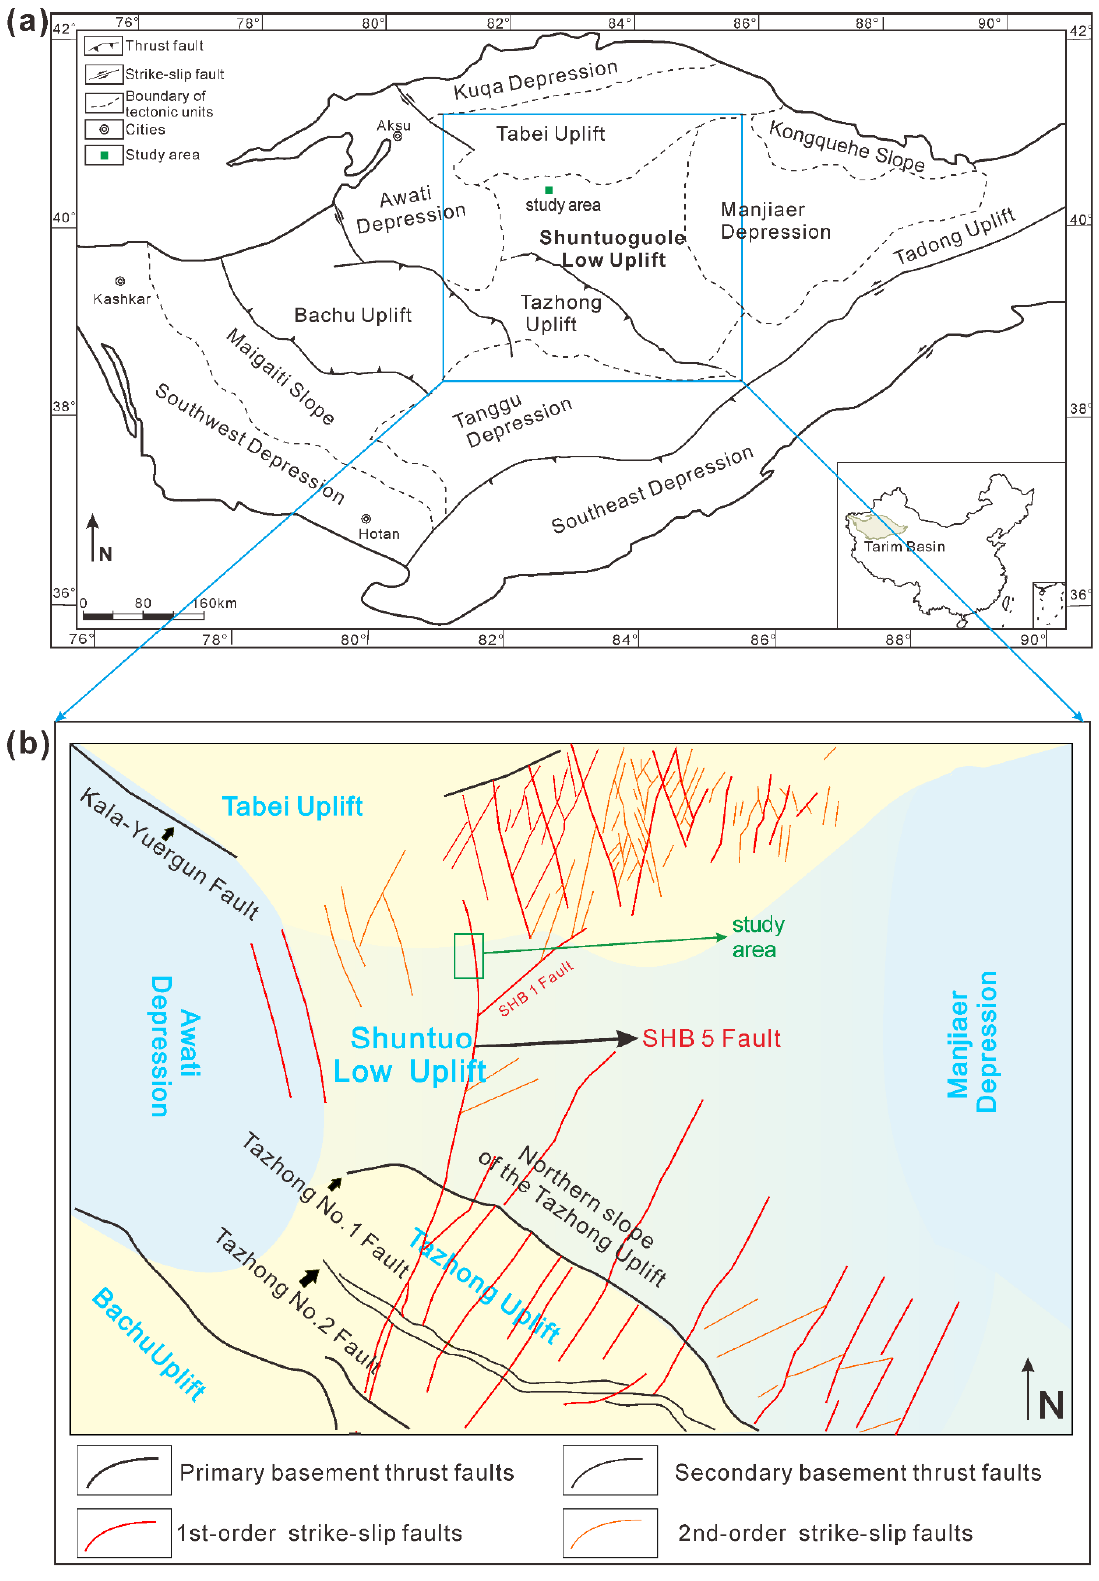
Figure 2. ( a ) Distribution map of the major tectonic units in the central Tarim Basin (modified from Deng et al., 2019) ( b ) Map of main fault system in the Shunbei area.